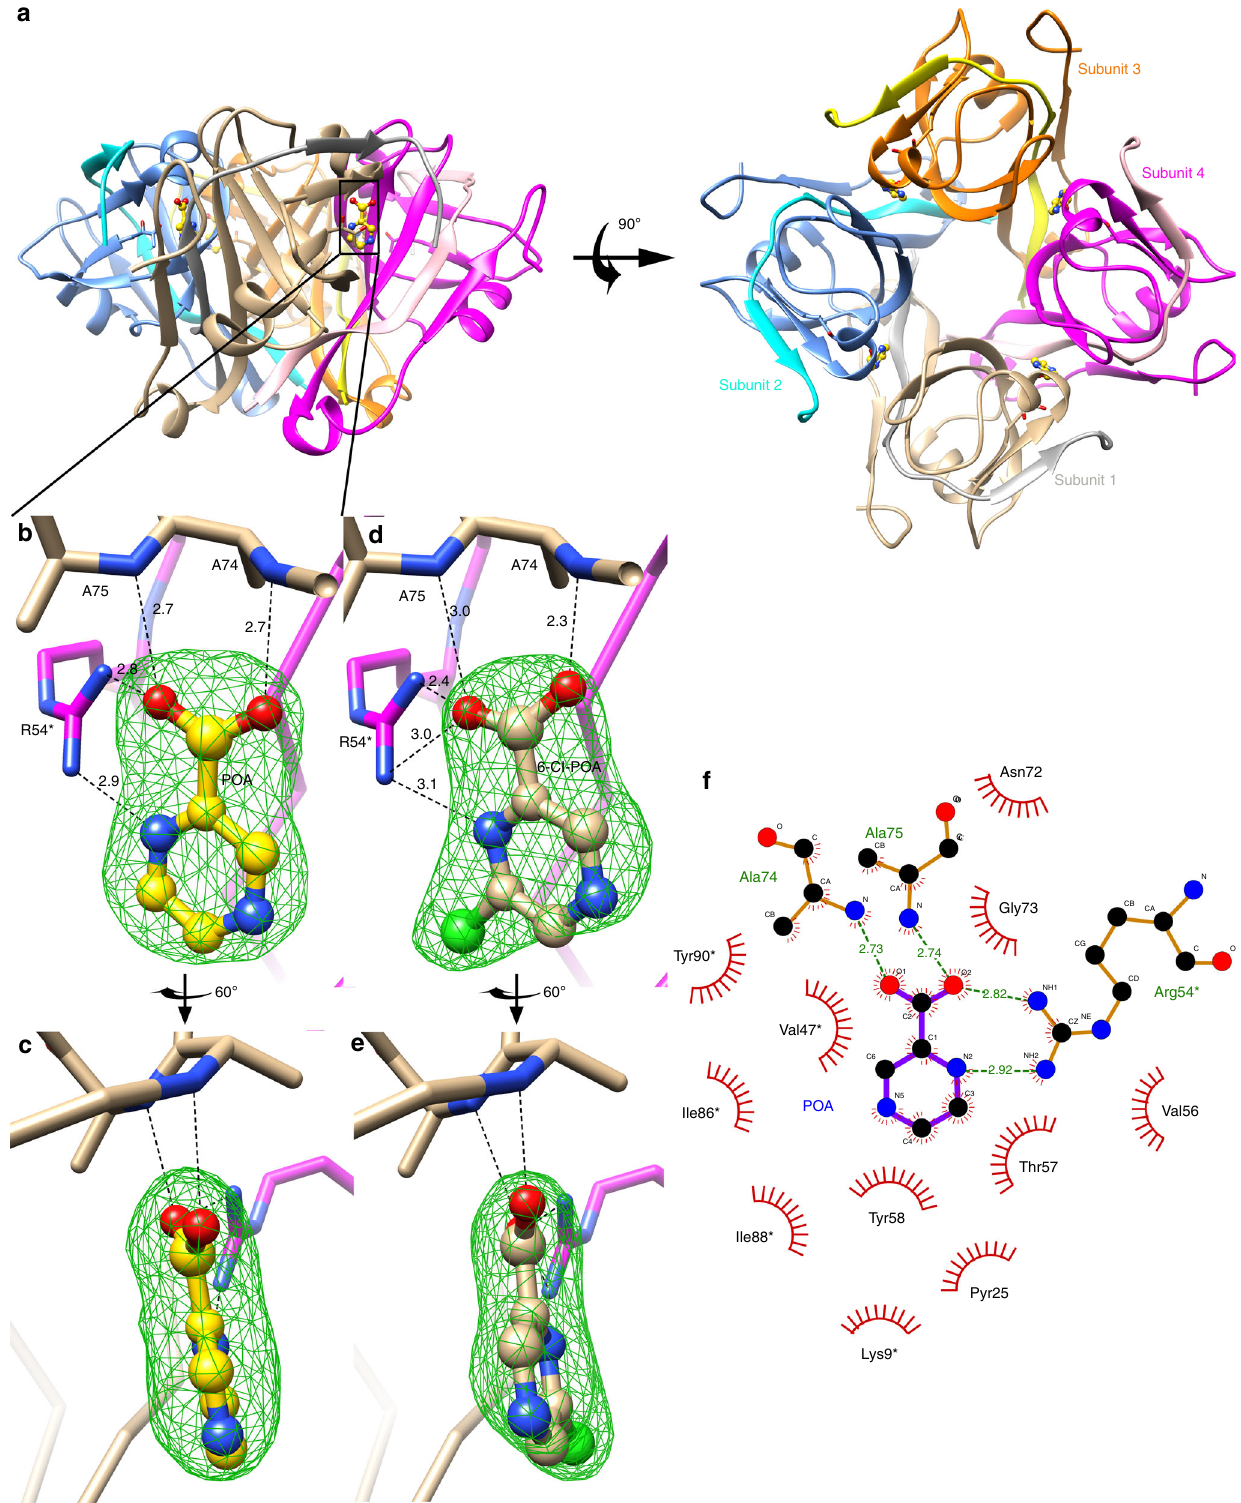
Fig. 2 Mtb PanD – POA interaction in the X-ray crystal structure. a POA binds Mtb PanD tetramer. The four subunits are shown in tan/silver, blue/cyan, orange/yellow, and magenta/pink. POA, shown in ball-and-stick, is bound to the active site at the interface of two PanD subunits. b Close up of the POA binding site. POA is shown with ball-and-stick with carbon in gold. The green mesh shows the polder omit map around POA at 3.5 σ . Hydrogen bonds around POA are shown in dash lines. c The view is turned 60° vertically. d , e 6-Cl-POA polder omit electron density. The PanD:6-Cl-POA is shown in the same view as PanD:POA in Fig. 2b, c. f POA shows extensive hydrogen bonding interactions with Mtb PanD. The interactions were analyzed and rendered with LigPlot + 27